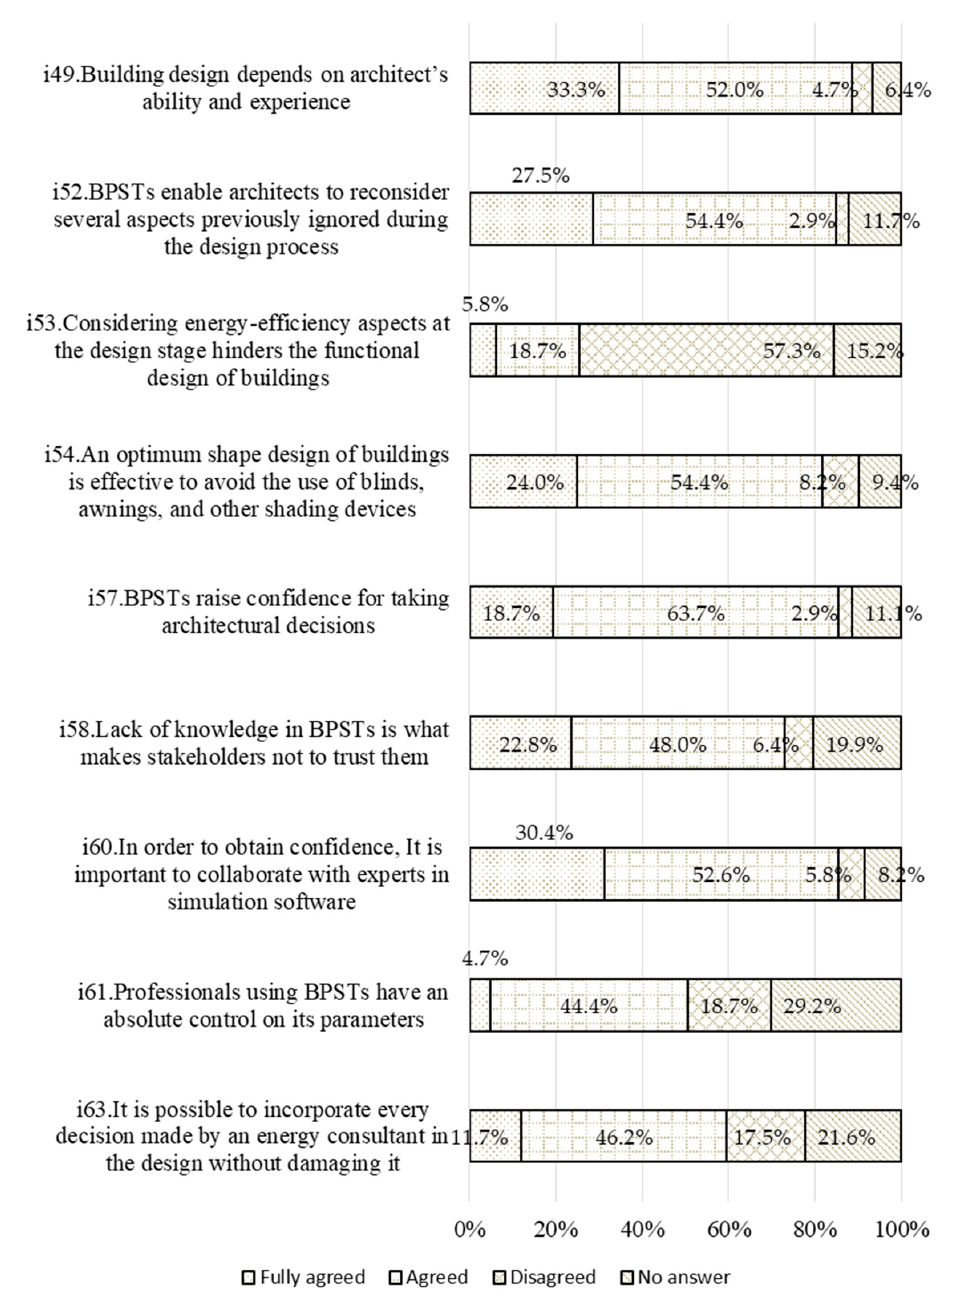
Figure 3. Relationship between BPSTs and architectural design, professional use, and the characteristics of BPSTs (respondents were users and non-users of BPSTs).